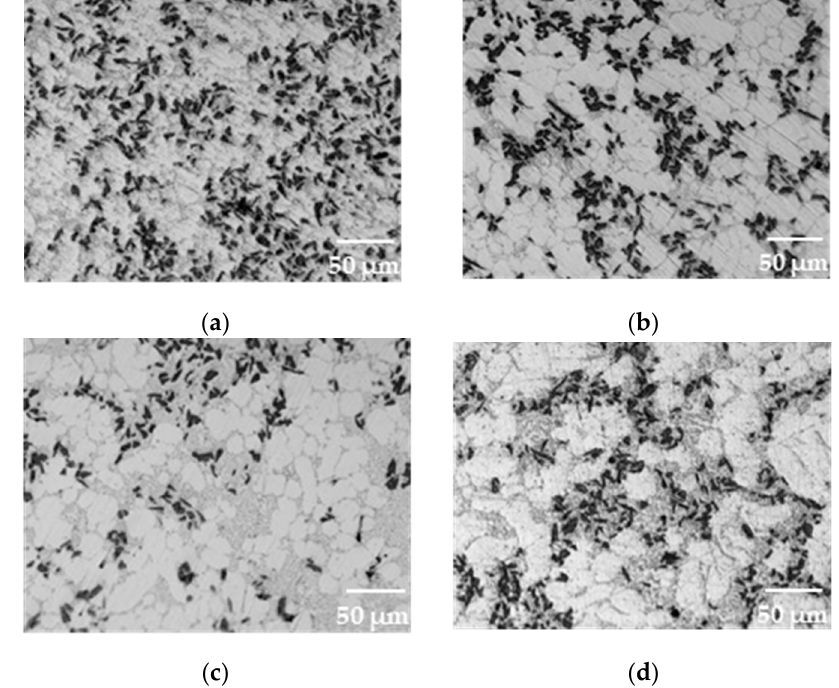
Figure 11. Cross - sectional microstructures of rheo - die-cast A356 / SiC ( 15%SiC - 15µm ) bar at Speed = 3 m / s and Pressure = 11 MPa in ( a ) position no . 1, ( b ) position no . 2 , ( c ) position no . 3, and ( d ) position no . 4 .